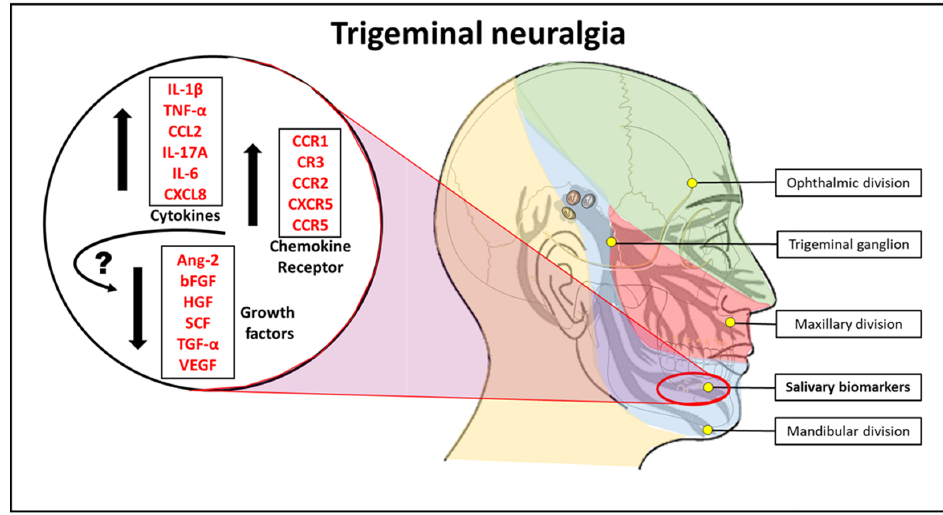
Figure 1. Pictorial abstract of the study. IL-4: Interleukin 4, IL-2: Interleukin 2, CXCL10: C-X-C motif chemokine ligand 10, IL-1 β : Interleukin 1 beta, TNF- α : Tumour necrosis factor-alpha, CCL2: C-C motif chemokine ligand 2, IL-17A: Interleukin 17A, IL-6: Interleukin 6, CXCL8: Interleukin 8, VEGF: Vascular endothelial growth factor, TGF- α : Transforming growth factor-alpha, SCF: Stem cell factor, HGF: Hepatocyte growth factor, bFGF: Basic fibroblast growth factor, Ang-2: Angio- poietin-2, CCR1: C-C chemokine receptor type 1, CR3: Complement receptor 3, CCR2: C-C chemokine receptor type 2, CXCR5: C-X-C chemokine receptor type 5, CCR5: C-C chemokine receptor type 5.